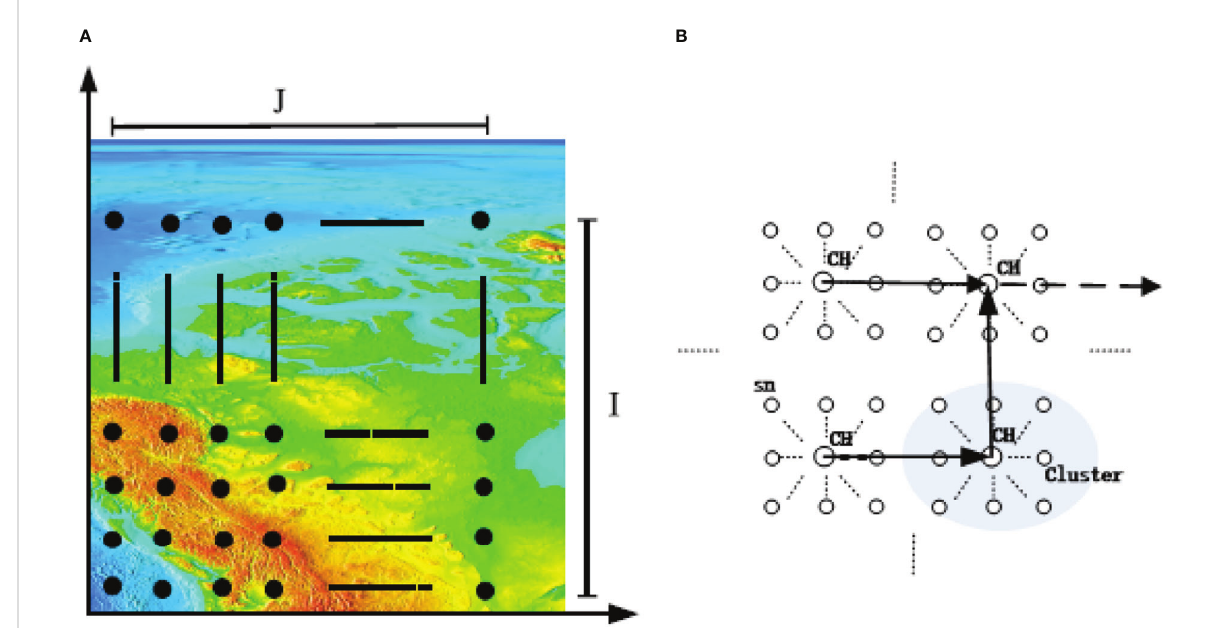
FIGURE 4 Network model. (A) Surveillance region where N SNs are distributed; (B) Clustered communication of regular